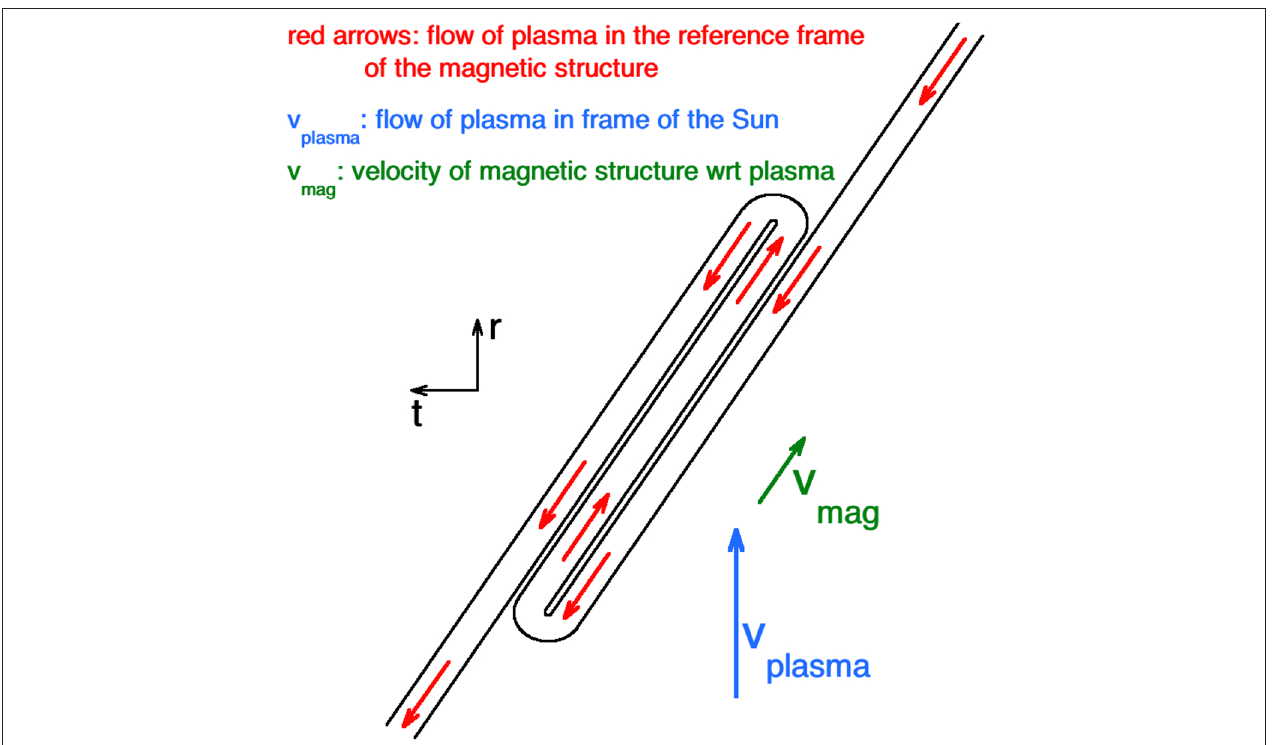
FIGURE 6 | A sketch in the ecliptic plane of a magnetic switchback (folded flux tube) and the associated velocity perturations. The Sun is at the bottom of the sketch. The sketched structure is approximately Parker-spiral aligned (see r-t coordinates in black). The red arrows are the flow of plasma in the reference frame of the magnetic structure, with the structure moving at a velocity v mag (green arrow) with respect to the average plasma flow v plama = v sw (blue arrow). A spacecraft crossing the folded flux tube sees a localized increase in the radial flow velocity where the magnetic field is reversed from the Parker spiral.